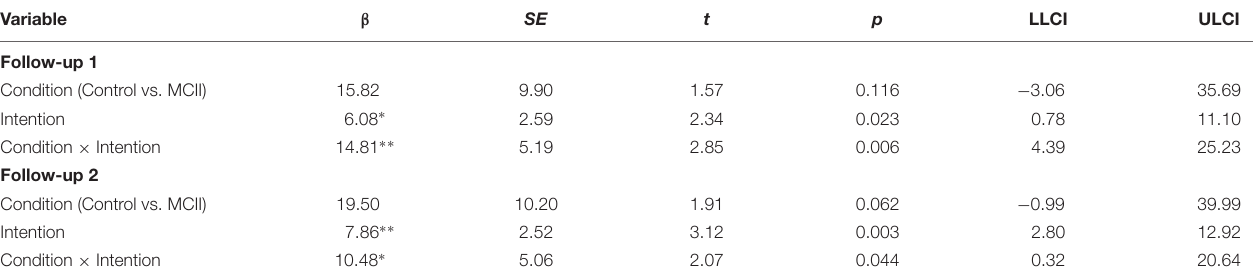
TABLE 2 | Linear regression of meat reduction on condition (Control vs. MCII), intention, and the interaction term. Variable β SE